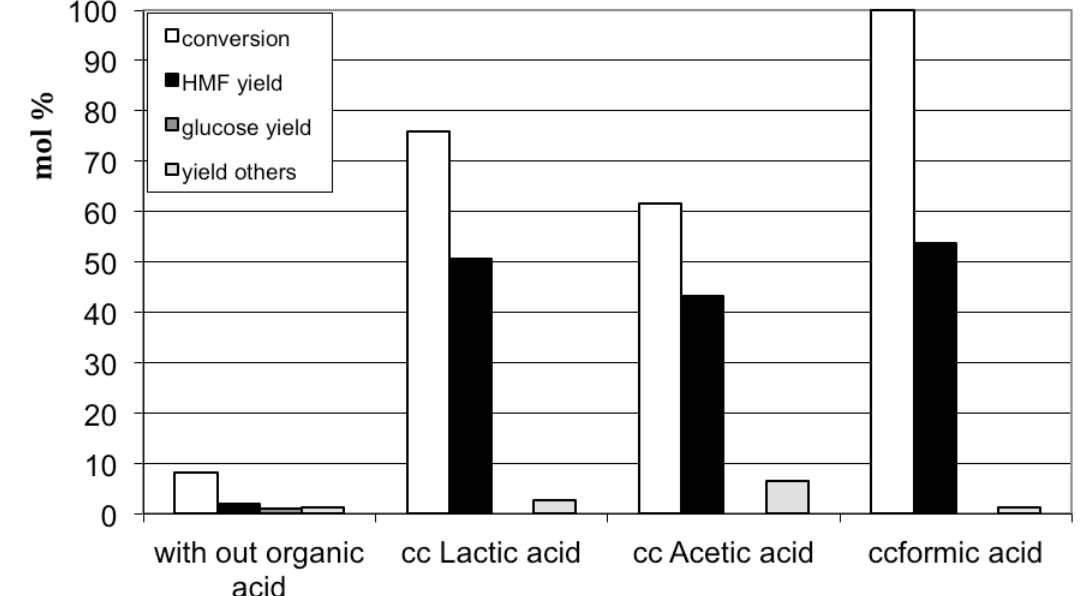
Figure 12. Fructose conversion in 5-HMF using concentrated aqueous solutions of 1 different carboxylic acids as reactive